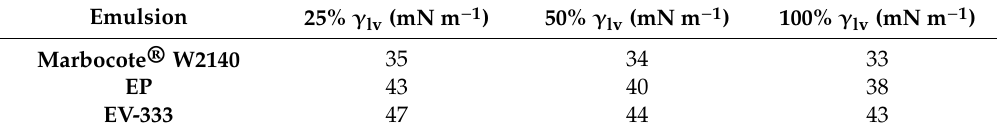
Table 3. Surface tension values for pure (100 %wt) and diluted (25 %wt, 50 %wt) release